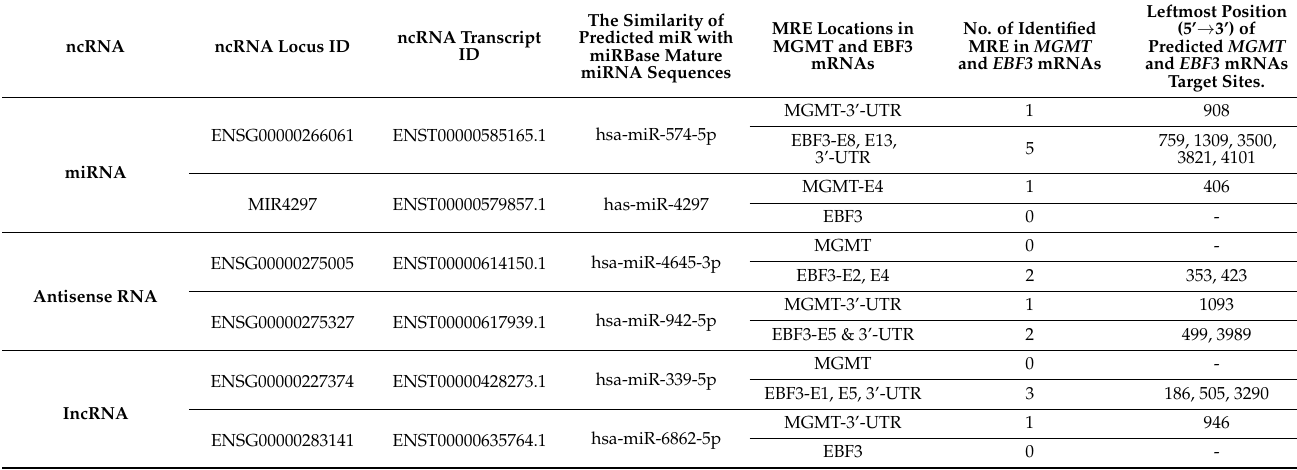
Table 3. Prediction of the human miRNA mature sequences (miR) in the ncRNA loci mapped at the MGMT - EBF region. Prediction is based on a search for similarity with miRBase mature miRNA sequences. The RNA22 v2 microRNA target detection tool was used to locate the predicted microRNA recognition elements (MRE) in the transcripts of MGMT (NM_002412.4) or EBF3 (NM_001005463.2). The predicted miR sequences bind and target the MRE of MGMT and EBF3 mRNAs. Abbreviations: miRNA: MicroRNAs, miR: mature miRNA product, hsa: human miRNA.